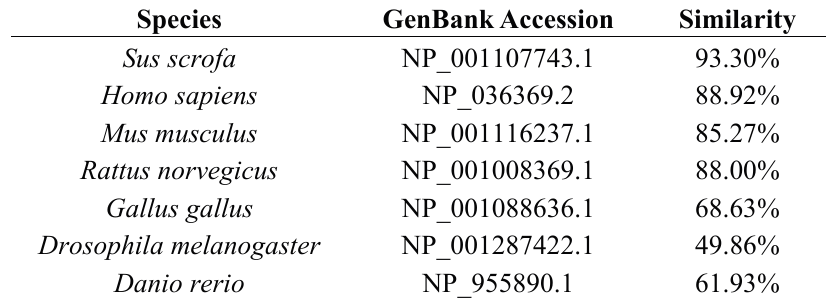
Table 1. Comparative analysis of SIRT2 gene amino acid sequence of different animals.